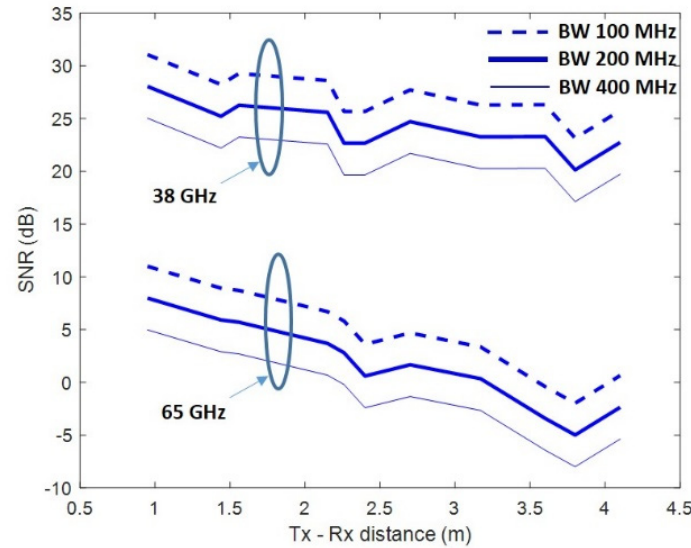
Figure 6. Measured SNR at 38 GHz and 65 GHz